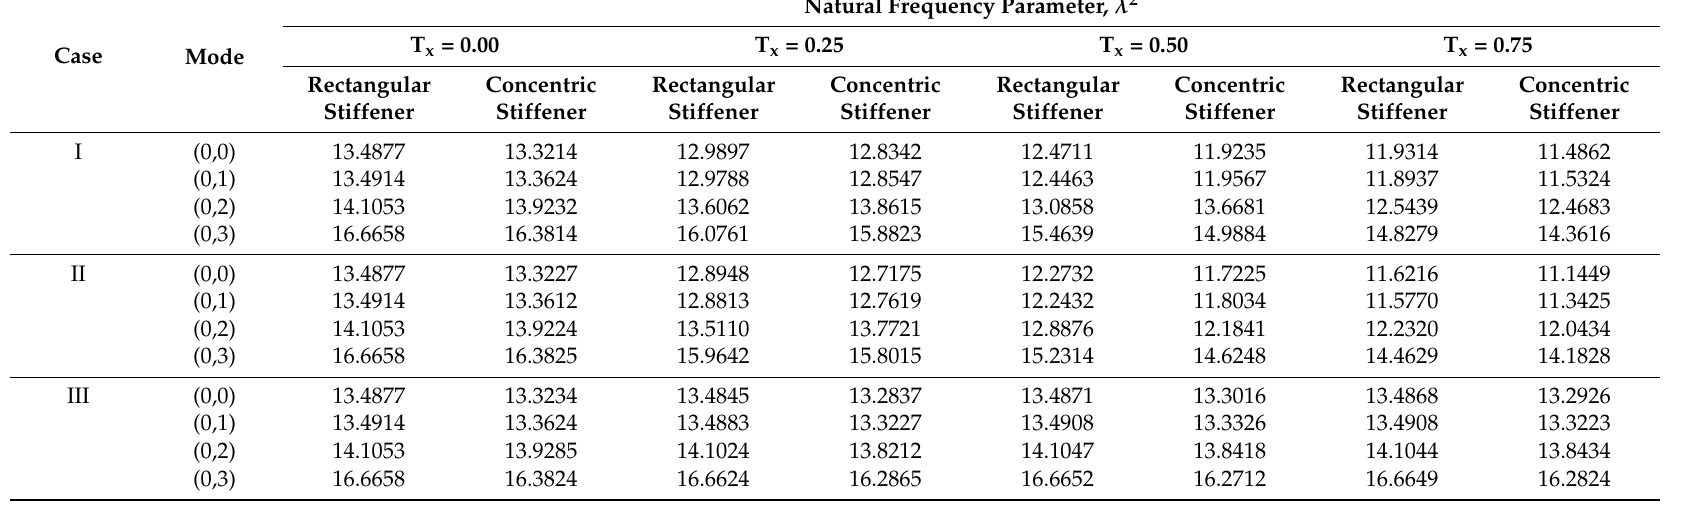
Table 6. Numerical comparison of natural frequency parameter λ 2 of plate with 4 rectangular and 4 concentric stiffener patches for different thickness variations and for different taper ratios T X